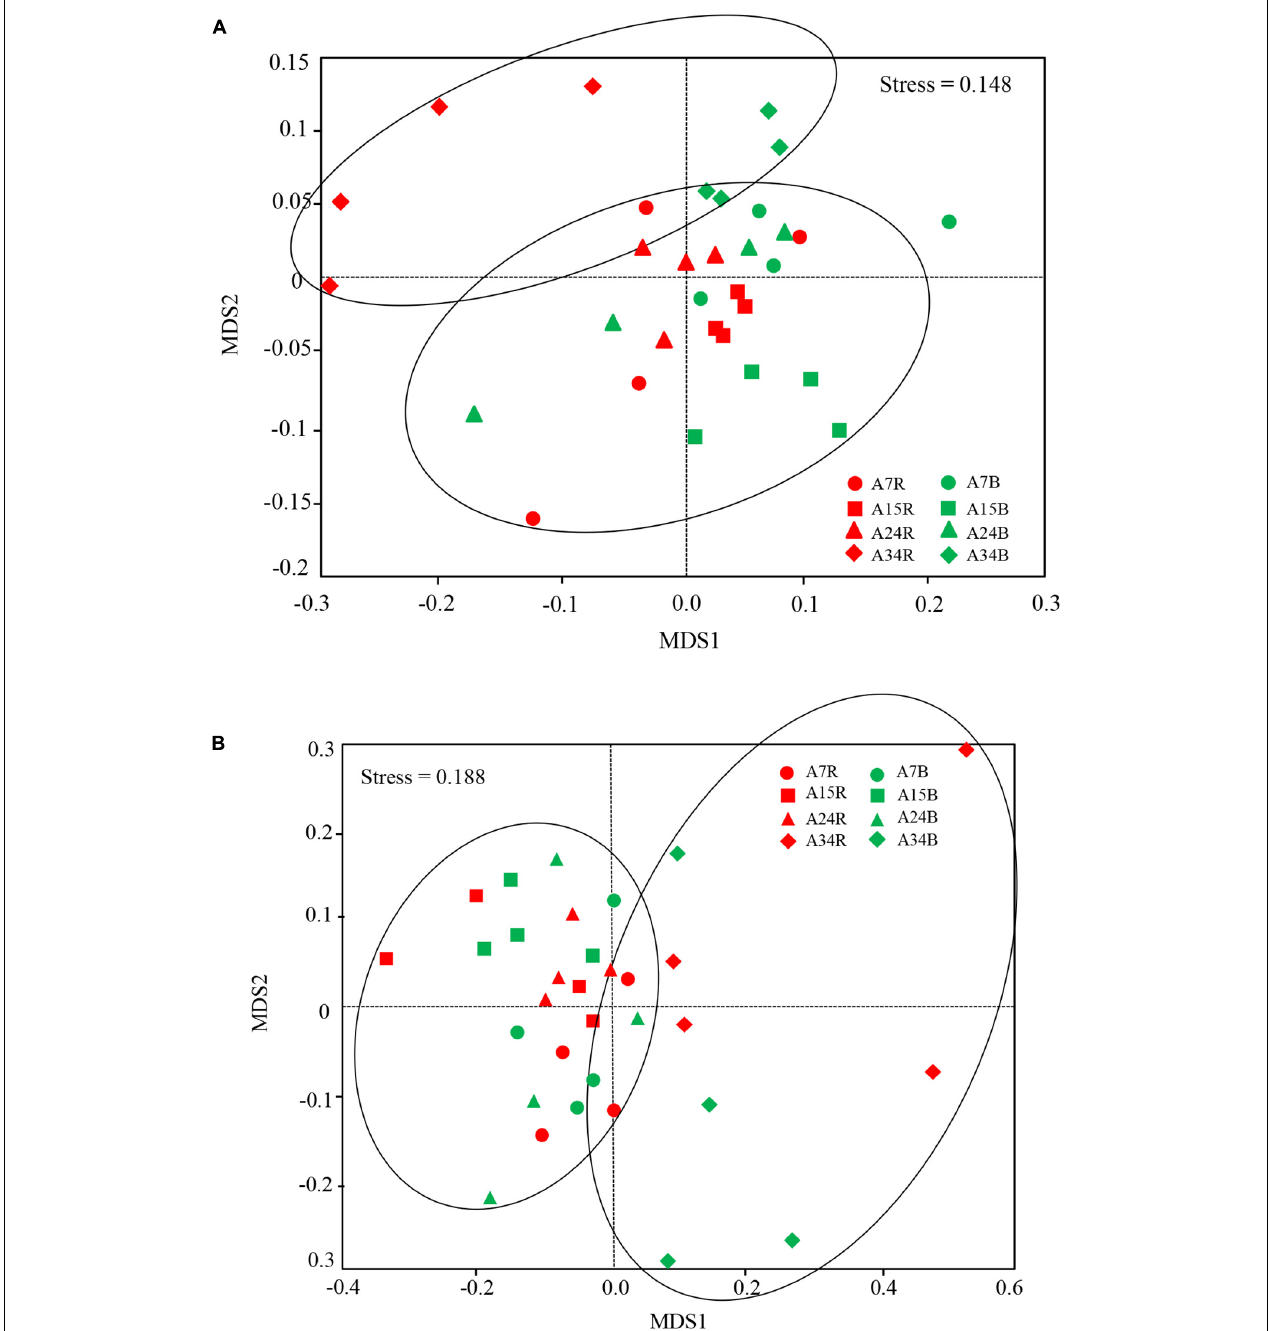
FIGURE 3 | Non-metric multidimensional (NMDS) scaling plot of bacterial (A) and fungal (B) community structures across all soil samples among different stand ages in Xinkou Forest Farm, Southeastern China. Stress value is indicated in the figure. Data points are from different stand ages (A7, A15, A24, and A34) and soil locations (R, rhizosphere soil; B, bulk soil). The samples with same stand age are represented in the same shape, while the samples in rhizosphere and bulk soil are represented by red and green